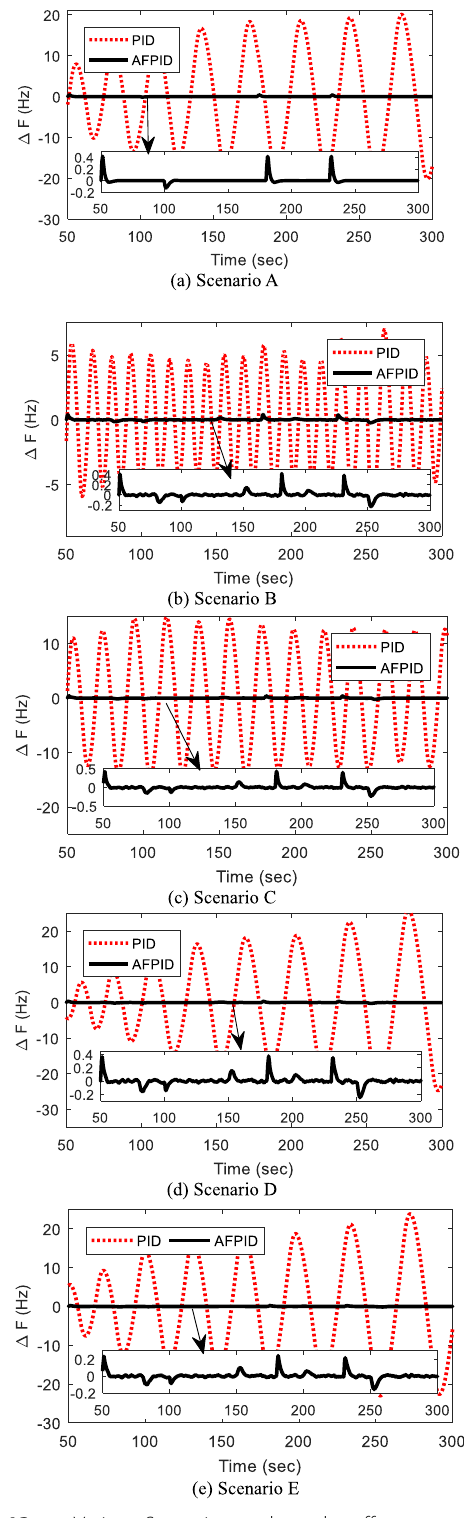
Fig. 13 a - e Various Scenarios to show the effect of